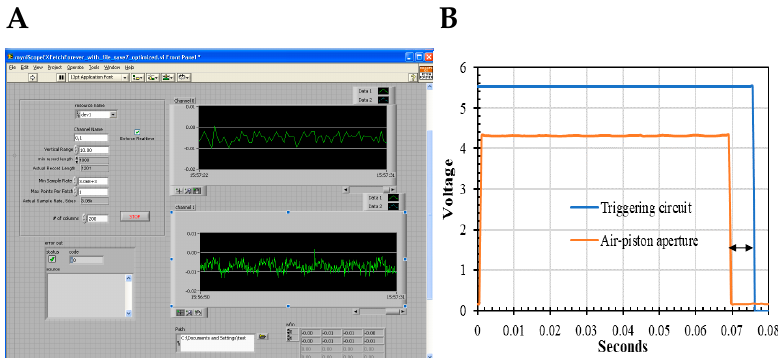
Figure 5. National Instrument front-screen interface for the dual-channel SF. ( A ) Channel 0 and channel 1 panels showing the V DC (t) and V AC (t) split signals, respectively, whose vertical range is 10 V from − 5